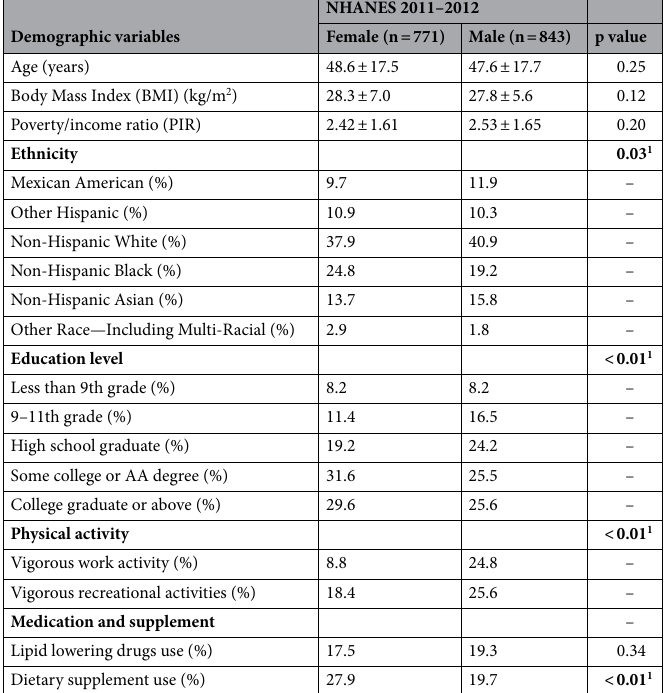
Dietary patterns. The dietary pattern scores were simplified as described in Methods in female and male populations by using food items with absolute factor loadings equal to or above 0.20 as being significant con- tributors to a pattern (Fig. 2). These simplified dietary pattern scores were used for all subsequent statistical analysis. Spearman analysis showed a statistically significant correlation between the original dietary scores and the simplified ones in both dietary patterns in female and male, respectively (female: DP1 r = 0.78, p = < 0.01; DP2 r = 0.85, p = < 0.01 and male: DP1 r = 0.84, p = < 0.01; DP2 r = 0.79, p = < 0.01). The simplified dietary pat- terns were referred to with an S (females: S-FDP; males: S-MDP). The food groups that contributed most or least to each dietary pattern in NHANES 2011–2012 are in Fig. 2. PUFAs and Zn intakes (response variables) were modest to moderately correlated with the simplified NHANES 2011–2012 extracted dietary patterns scores after adjustments of energy intake (Table 2). Specific foods consumed by females.